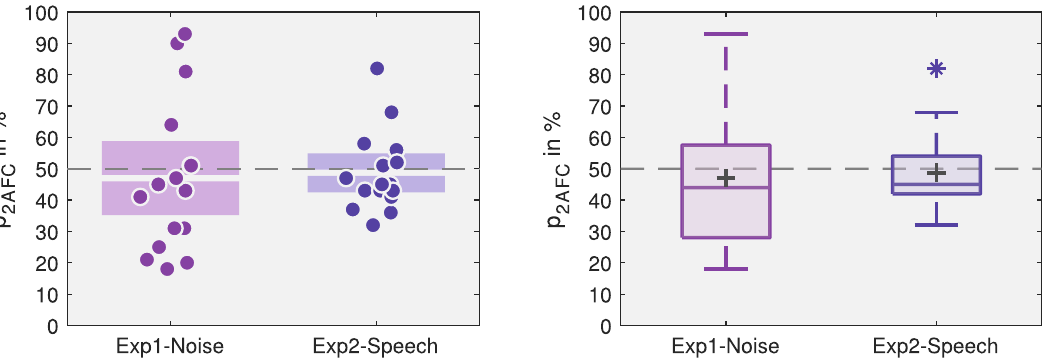
Figure 4. Results of the 2AFC test in Experiment 1 (Exp1-Noise) and Experiment 2 (Exp2-Speech). The left plot shows the determined individual percentages of correct answers p 2 AFC as points (horizontal offset for better readability). The boxes show the mean (box notch) and the 95% between-subject CI. The gray dashed line denotes 50% chance level. The right plot shows the interindividual variation in the determined p 2 AFC values in the form of a box plot with the median (box line), the mean (cross), and the (across participants) interquartile range (IQR); whiskers display 1.5 (cid:1) IQR below the 25th or above the 75th percentile and outliers beyond that range are indicated by